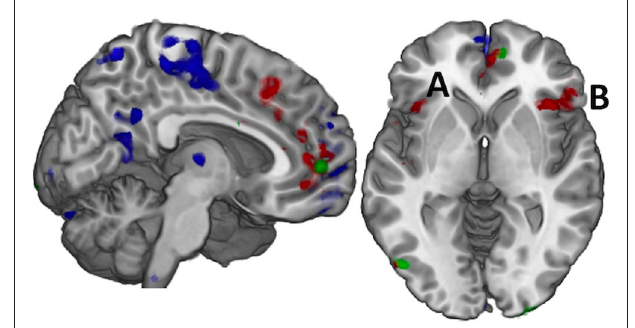
FIGURE 1 | Effort and Fatigue in the Constant Effort task demonstrated differing regional effects with effort associated with caudal, medial prefrontal cortex (red) while fatigue was associated with rostral prefrontal cortex as well as postcentral and posterior cingulate cortex (blue). Controls demonstrated significantly higher activity than mTBI in a small area of the right medial prefrontal cortex (green) while mTBI had more activity in the posterior occipital cortex, but there were no other significant group effects. When these regions were used in computing functional connectivity, it was only the connectivity amongst the regions of the effort effect (red) that demonstrated group differences in connection strength. For example, the connection between the left insula (A) and the right inferior frontal gyrus ( B , pars orbitalis) was significantly stronger in the TBI group for time on task at 75% effort.